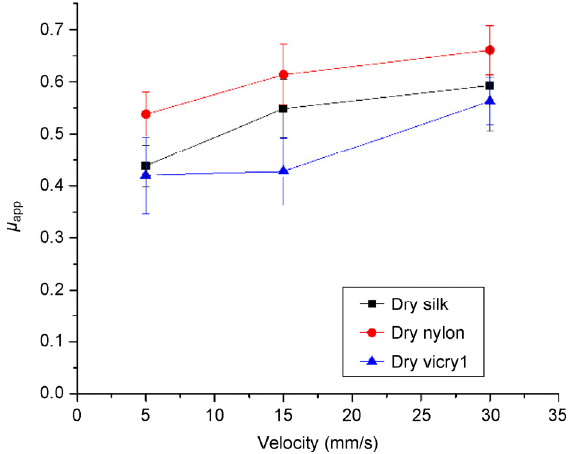
Fig. 7 Apparent coefficient of friction of silk, vicryl, and nylon at various velocity, under 0.20 N applied